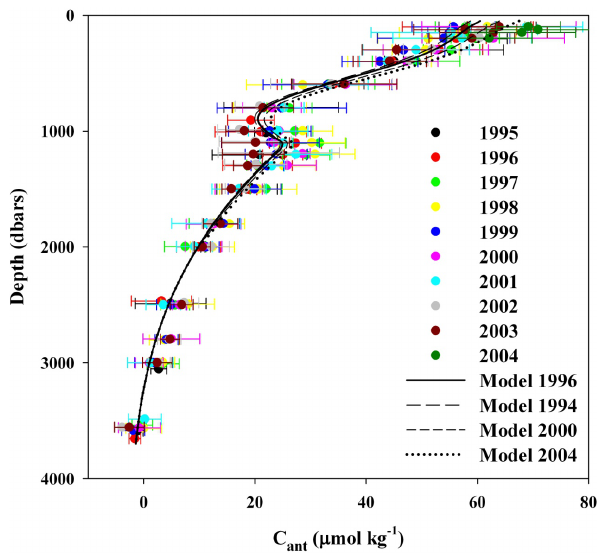
Fig. 11. The concentration of anthropogenic CO 2 for the period 1995 to 2004, averaged for each year and sampling depths and plot- ted together with their standard deviation. A fitting order 5 poly- nomial function for the year 1996 is plotted together with predicted values for the years 1994, 2000 and 2004, assuming oceanic phys- ical and biological conditions to be stable and the rate of anthro- pogenic CO 2 increase given by the rate of C T increase in Table